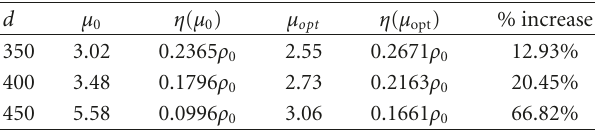
Table 1: Capacity gain in the modified Manhattan network with di ff erent lengths of